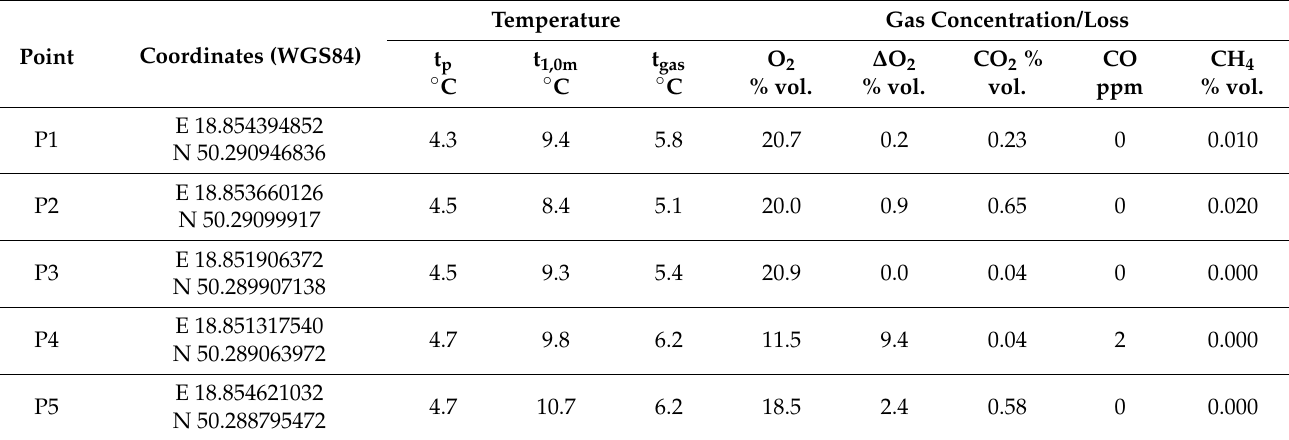
Table 2. Measurement result during the 1st measurement session (own